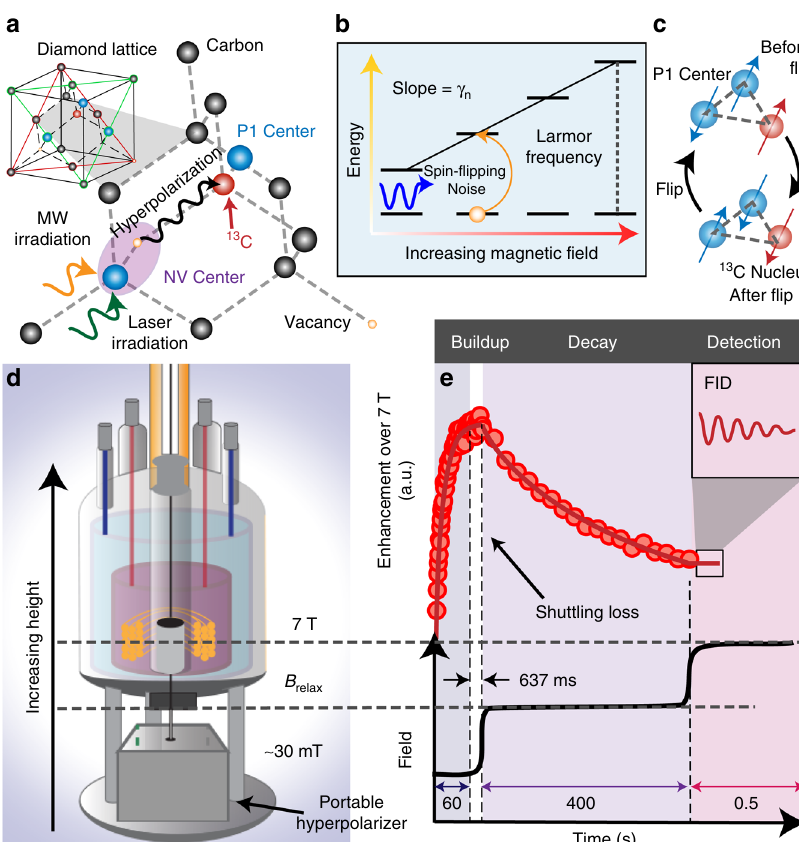
Fig. 1 Principle. a System consisting of 13 C nuclear spins in diamond hyperpolarized via NV centers allowing their direct measurement by bulk NMR. Lattice also contains electronic spin bath of P1 centers. b Changing magnetic fi eld allows probing of spin- fl ipping noise that is resonant with the carbon Larmor frequency. c Dominant T 1 relaxation mechanism via three-body fl ip- fl ops with pairs of P1 center electrons. d Experimental platform. Portable hyperpolarizer is schematic steps of laser-driven optical 13 C hyperpolarization for (cid:1) 60s at B 30 mT, rapid shuttling ( < 1 s) to the fi eld of interest B , relaxation, and pol (cid:5) relax (points) is quanti fi ed by its enhancement over the 7 T Boltzmann signal. Signal growth and decays are fi tted to stretched exponentials (solid